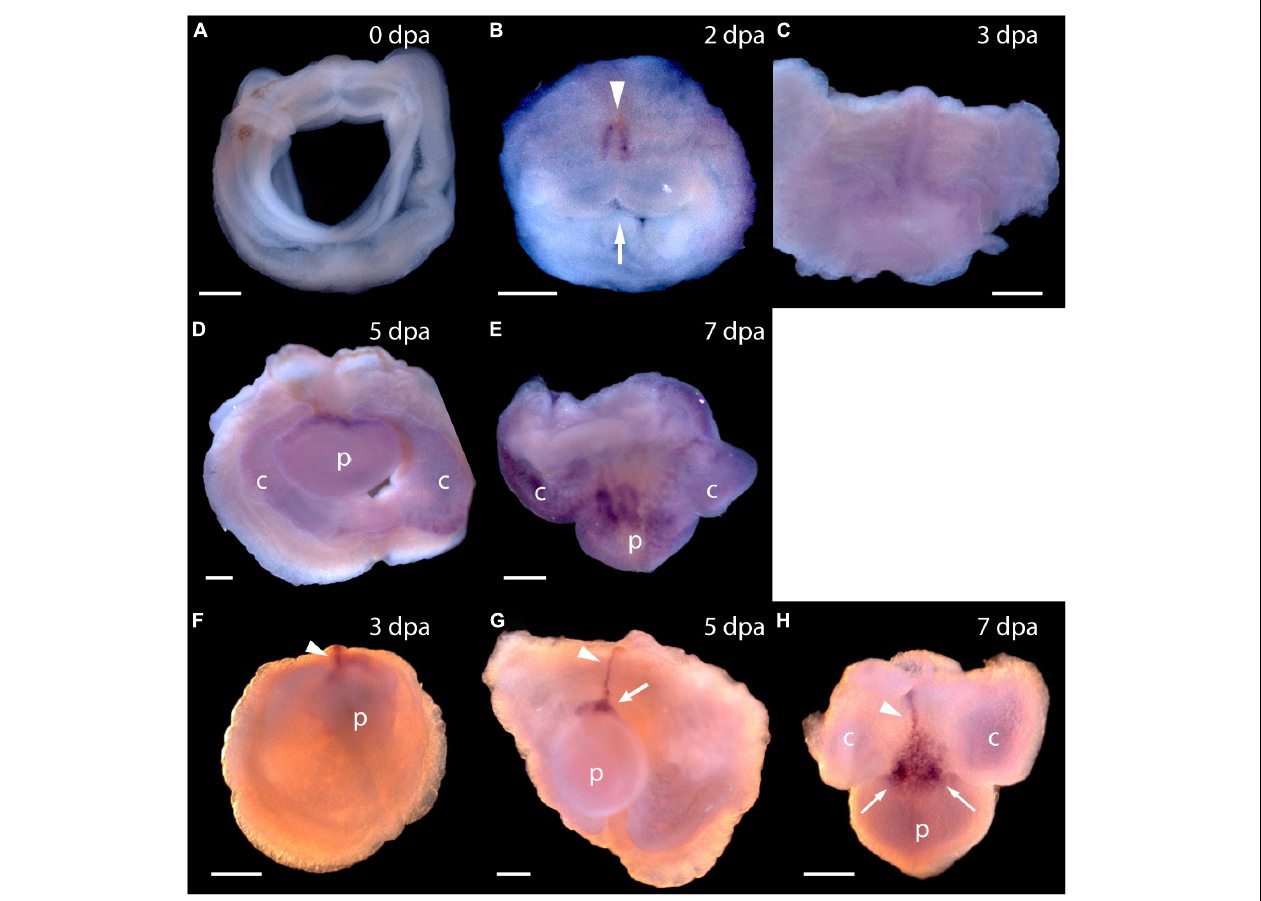
FIGURE 4 | Expression of Pf-Pou3 and Pf-Msxlx during head regeneration. (A–E) Whole mount in situ hybridization of Pf-Pou3 . (A) At 0 days post-amputation (dpa), no signal is detected in the tissue at the site of transection. (B) At 2 dpa, signal is first detected along the dorsal mid-line (arrowhead) just posterior to the site of transection. Note that at 2 dpa the wound edges are swollen and the wound is still open to the gut (arrow). (C) At 3 dpa, the wound has closed and signal along the dorsal midline has extended anteriorly into the base of the nascent blastema. (D) At 5 dpa and (E) at 7 dpa (dorsal view), a strong signal at the base of the blastema and forming head continues during the course of regeneration. At this time, a weak signal appears throughout the blastema and forming head. (F–H) In situ hybridization of Pf-Msxl x. (F) At 3 dpa, signal is evident along the dorsal nerve track (arrowhead). (G) At 5 dpa and (H) at 7 dpa (dorsal view), signal has extended along the dorsal mid-line to the base of the blastema where it widens into a triangle (arrows). This pattern of expression continues as the new head develops. p, nascent proboscis; c, nascent collar. Dorsal is up in all frames, unless noted. Scale bars = 0.25